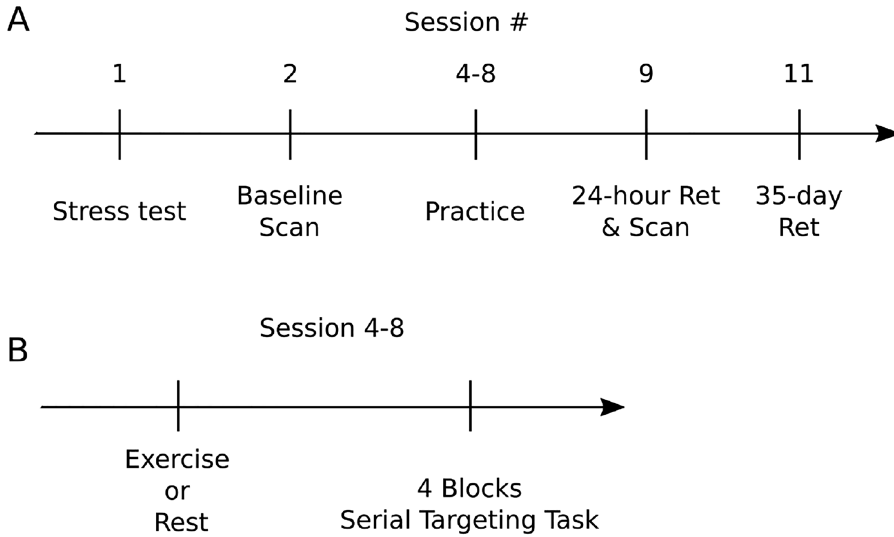
Figure 1. Experimental design of: ( A ) the entire study and ( B ) an exercise or rest practice session. Regardless of group, all participants completed a maximally graded stress in session 1. Session 2 and 3 contained baseline a assessment of the motor task and a MRI resting state scan, respectively. In sessions 4–8 participants either watched 23 min of a nature documentary or underwent 23 min of high-intensity interval exercise before practicing the implicit motor task. Session 9 contained the 24-h, short-term retention test to assess motor learning and post-training MRI session. Session 11 included the 35 day, long-term retention